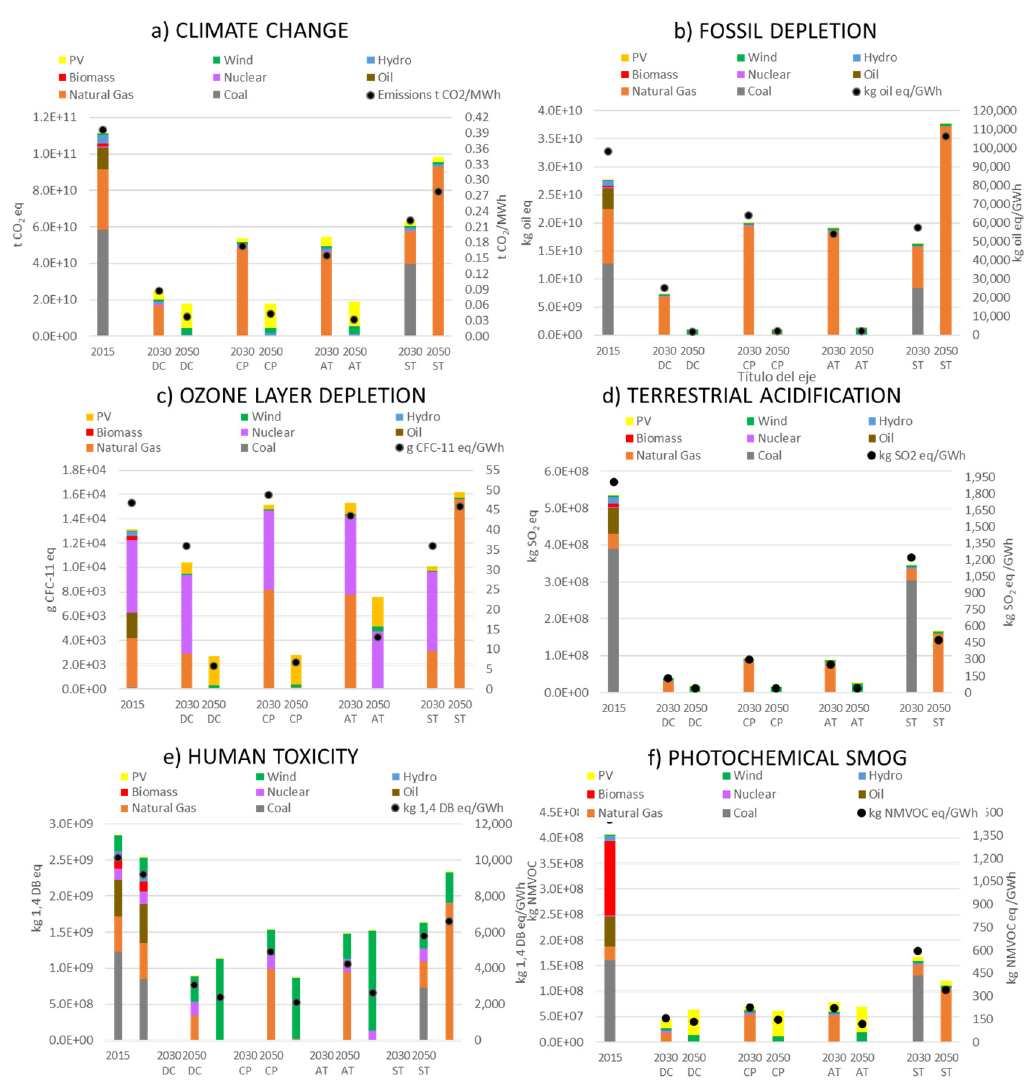
Figure 9. Environmental performance of future projections of Spain’s electricity system: 2030–2050: ( a ) climate change, ( b ) fossil depletion, ( c ) ozone layer depletion, ( d ) terrestrial acidification, ( e ) human toxicity, ( f ) photochemical smog.